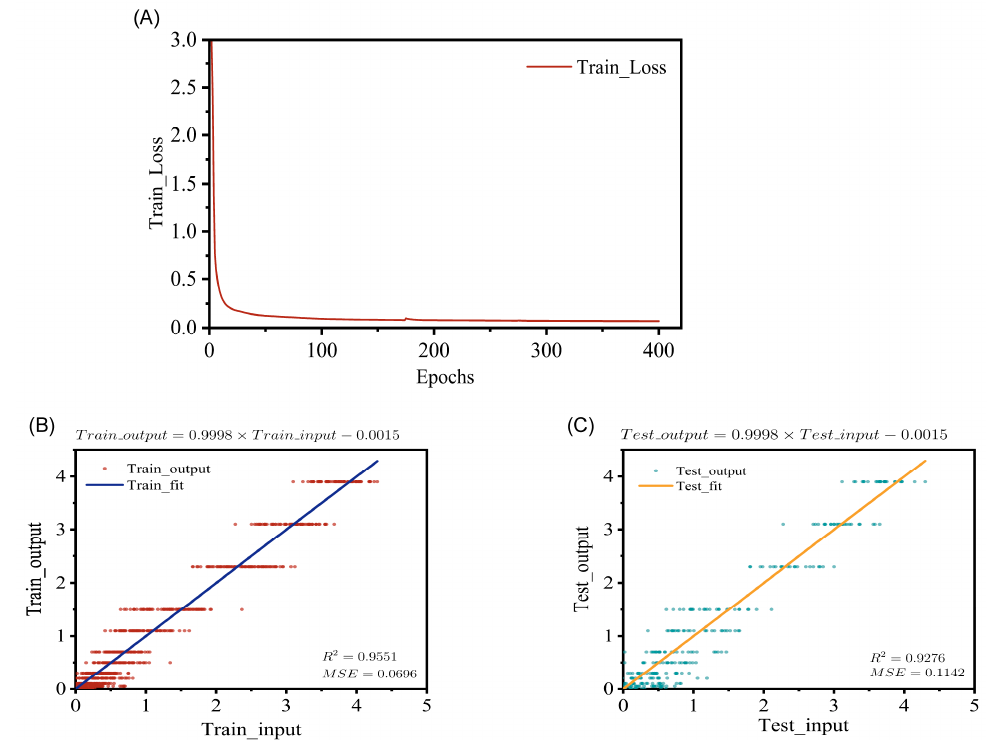
Figure 4. ( A ) The training curves. The maximum number of training events was 1000 epochs, and the training mean square error was 0.07. ( B ) The specific training set fitting situation. ( C ) The specific test set fitting situation.